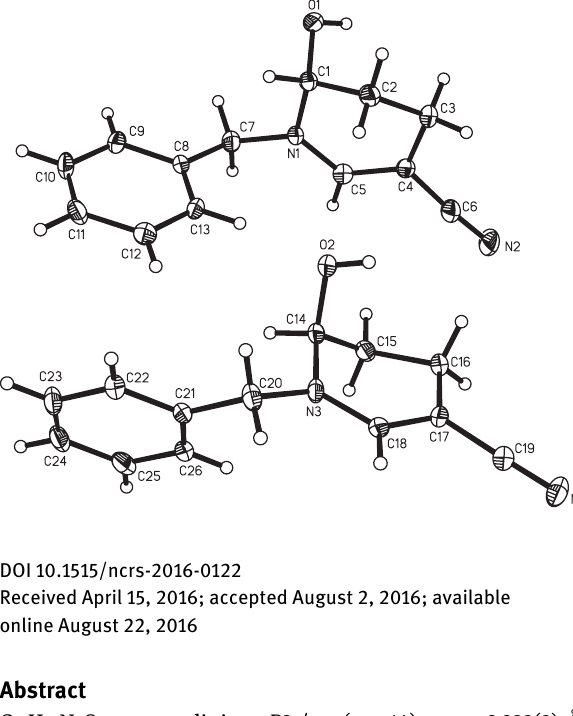
Table 1: Data collection and handling.